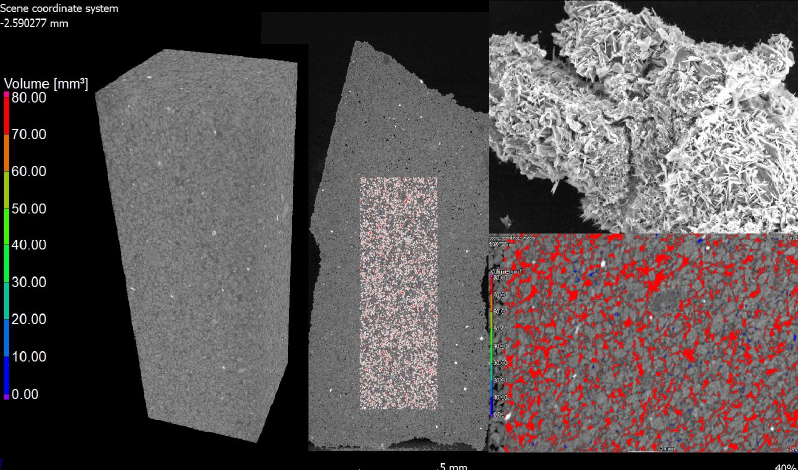
Figure 18. Computer tomography—an image and a three-dimensional cross-section through a sample of silicate brick modified by glass sand (90% GS, laboratory production).